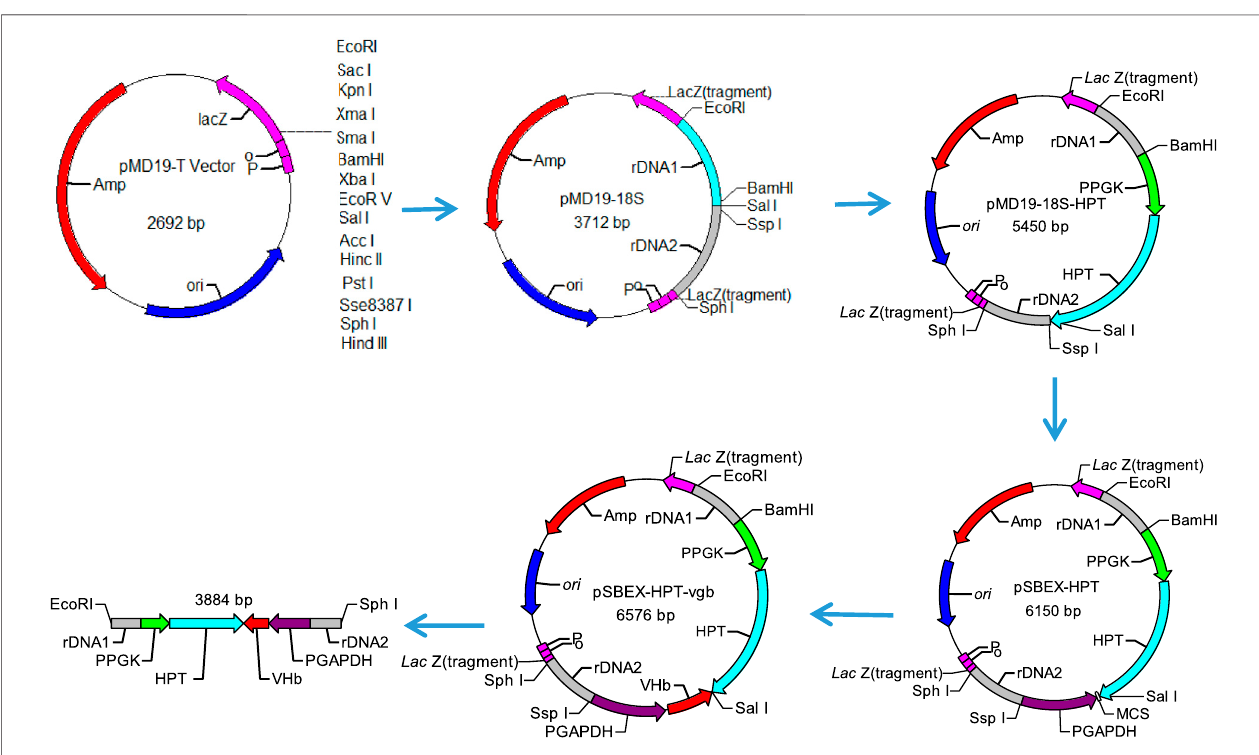
FIGURE 1 | Construction of the plasmid pSBEX-HPT-vgb used for S. bombicola transformation.